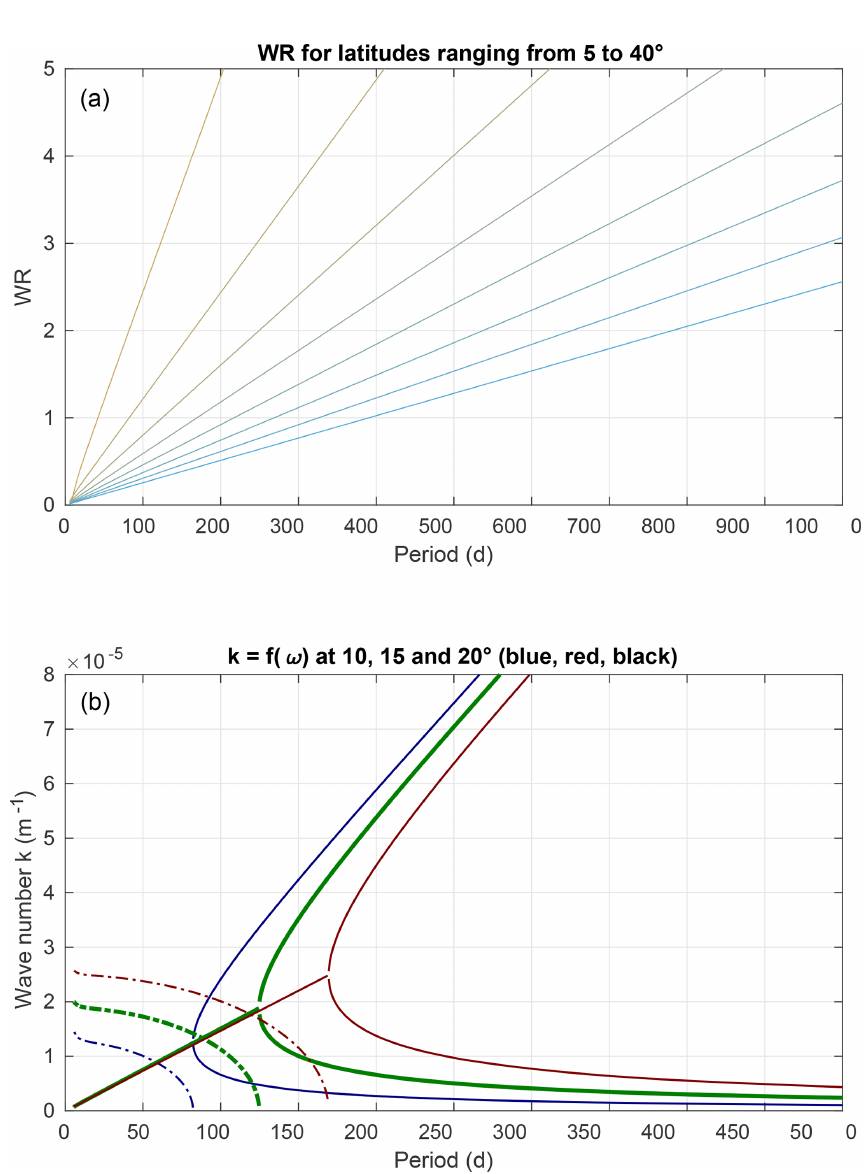
Figure 12. (a) W R is shown for latitudes ranging from 5 ◦ N (left segment) to 40 ◦ N (right segment). The critical value W R = 1 is reached at 15 ◦ N for a period of about 125d. (b) Wavenumber k as a function of the period T for three different latitudes (10 ◦ (blue), 15 ◦ (red), and 20 ◦